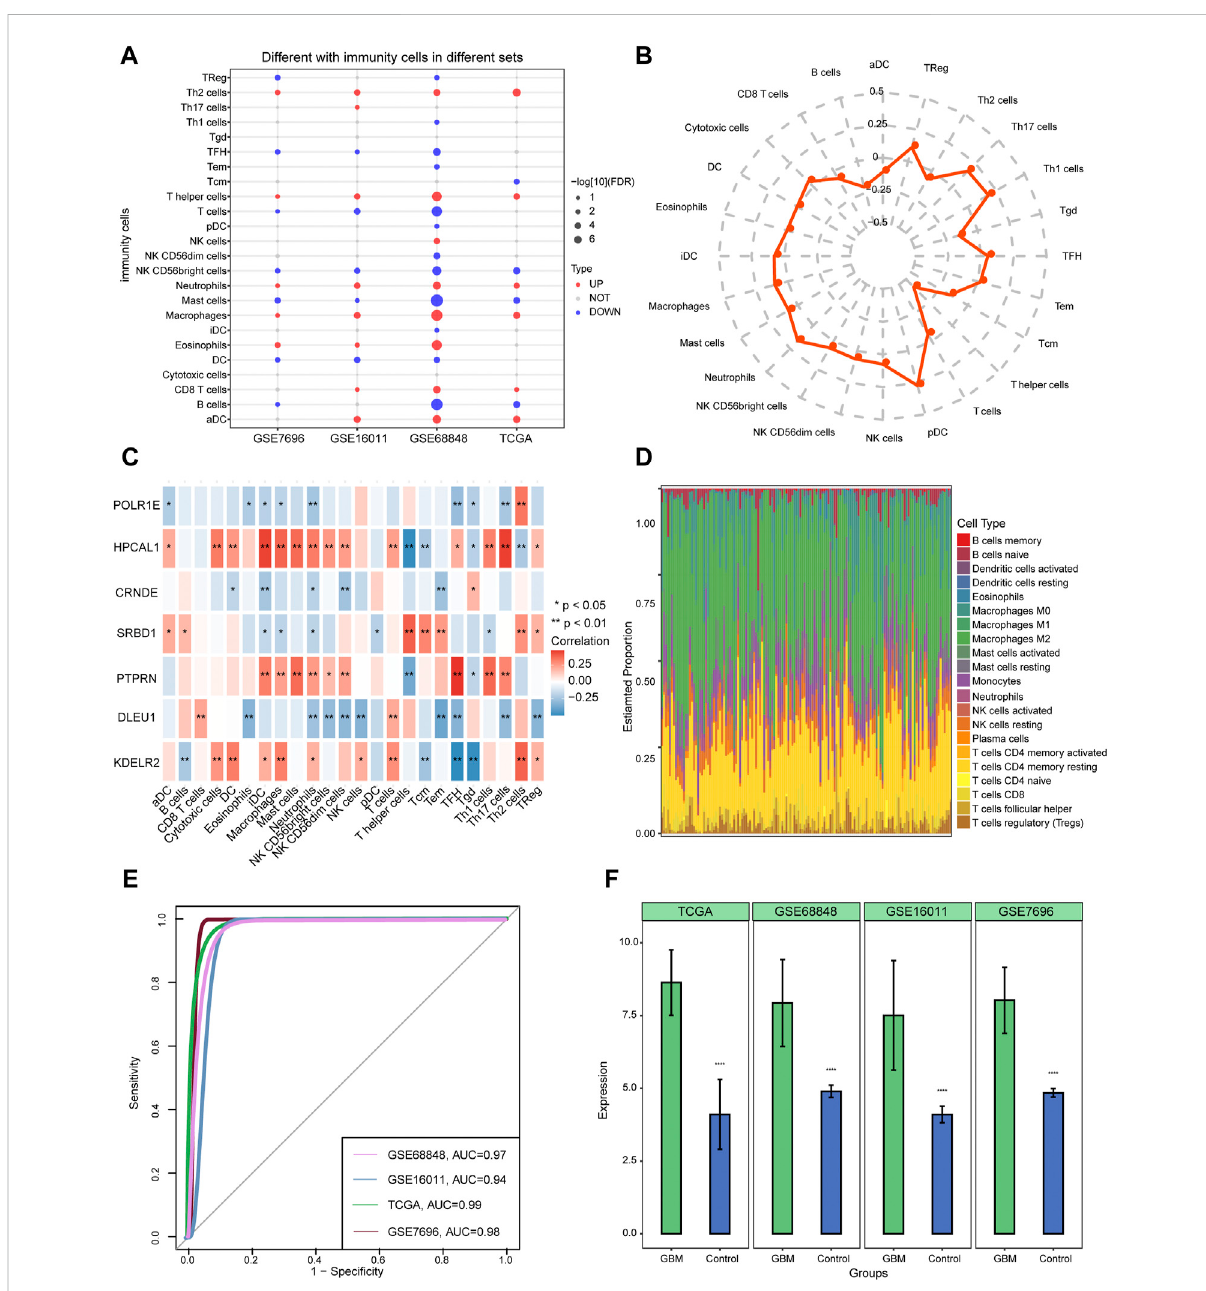
FIGURE 7 Identifying immune cell in fi ltration in glioblastoma (GBM) and expression of CRNDE in four datasets. (A) Twenty-four immune cell types were used to constructed ssGSEA in four datasets. Red dots indicate the high-in fi ltrated immune cell types and blue dots indicate low-in fi ltrated immune cell types. (B) Radar chart shows the correlation between immune cells and seven hub gene-risk score. (C) Pearson ’ s correlation shows the correlation between immune cells and seven hub genes. (D) Distribution of 22 immune cell types in each sample from TCGA using the CIBERSORT tool. (E) The area under the curves (AUCs) of CRNDE in four datasets. (F) The expression of CRNDE between GBM and controls. **** p < 0.001. GBM,